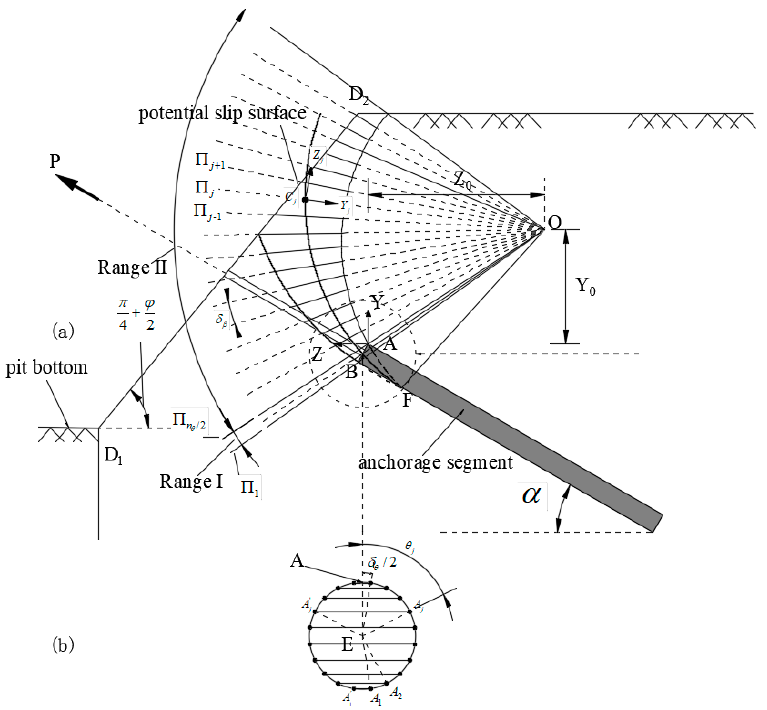
Figure 6. Spatial discretization technique for the generation of the failure model: ( a ) profile diagram, ( b ) front-end surface of the anchorage segment.